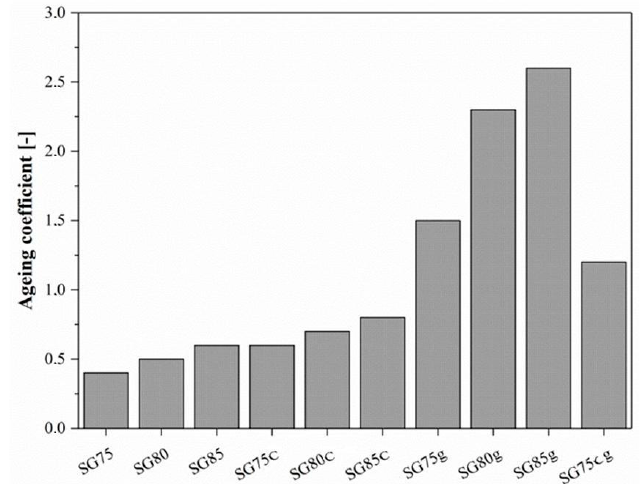
Figure 9. E ff ect of starch and glycerin content and of the addition of casein or gelatin as modifiers on the thermo-oxidative aging resistance of starch-based composites.